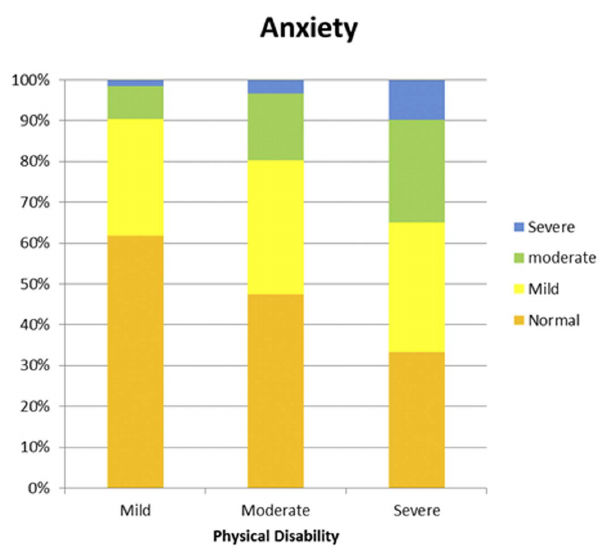
Figure 2. The proportions of people with low, moderate or high physical disability experiencing depression. This shows the proportions of people reporting normal ( , =7), mild (8–11), moderate (12–15) or severe ( . 15) depression were assessed against low, moderate and high tertiles of physical disability. Greater numbers of the respondents reported symptoms of depression with increasing levels of disability, and the numbers of people with higher levels of depression also